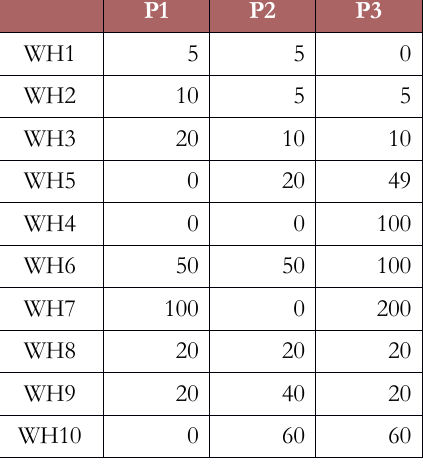
Table 4. Demand by